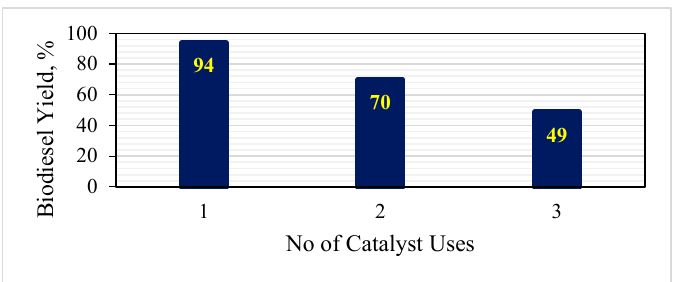
Figure 7. EAFS Reusability.